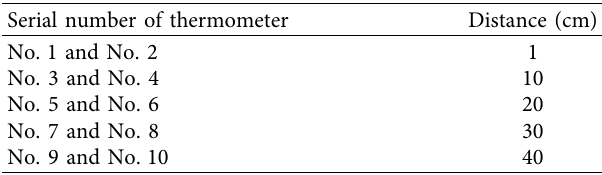
Figure 1: Test design process. (a) Steel drum and wetting coal. (b) Pressurized coal sample. (c) Coal body after embedding thermometers and injecting tube. (d) Liquid nitrogen injection. (e) Temperature display and recording. (f) Layout of thermometers. Table 1: The layout of